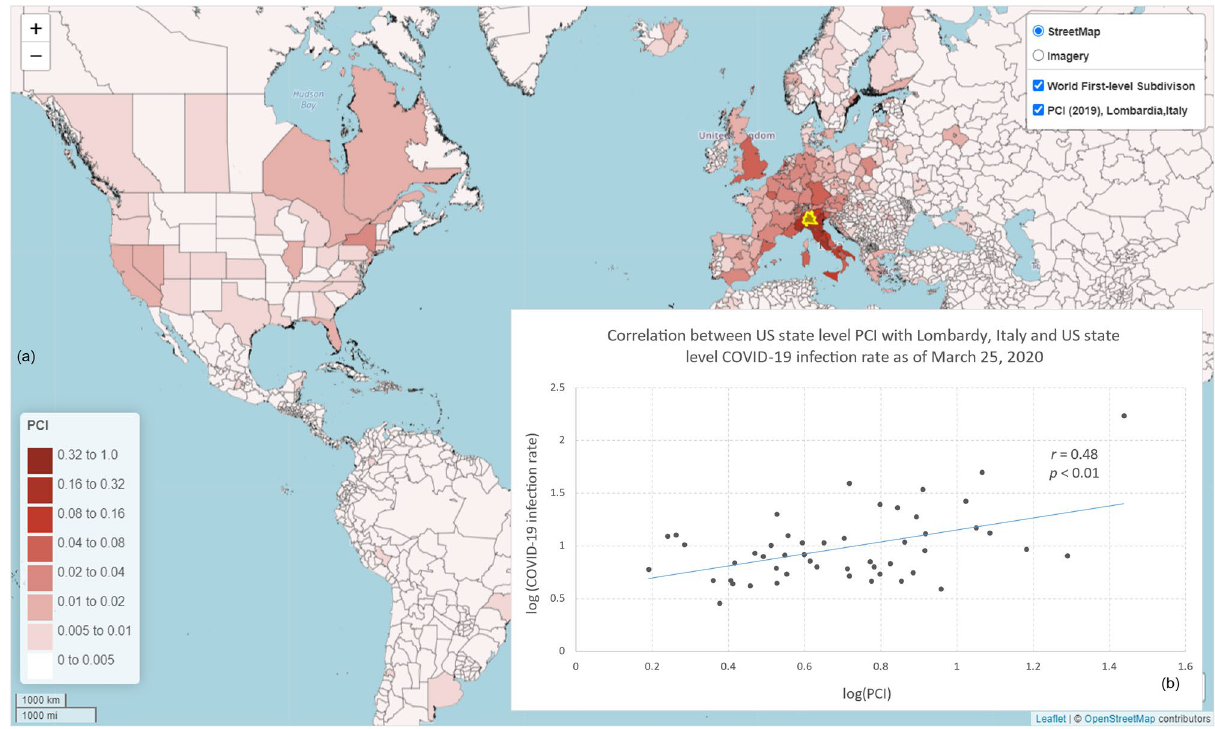
Figure 14. Global scale analysis of PCI and COVID-19 infection rate. ( a ) Map showing the 2019 world first- level subdivision PCI between Lombardy, Italy and US states (and other parts of the world); ( b ) Correlation between the log US state level PCI with Lombardy, Italy and log US state level COVID-19 infection rate (number of cases per 100,000 people) as of March 25, 2020. COVID-19 case data were downloaded from NYT Github 62 . The state population was retrieved from the ACS 5-year estimates (2014–2018). World first- level subdivision boundary data was retrieved from GADM 56 . The PCI maps were generated by the web portal developed by the authors using Leaflet (version 1.7). The base map is from OpenStreetMap contributors, licensed under the Open Data Commons Open Database License (ODbL) by the OpenStreetMap Foundation (OSMF). https:// www. opens treet map. org/ copyr